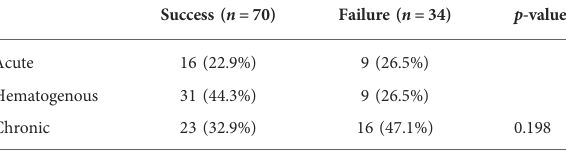
TABLE A1 Compare the failure rate of different types of infection with the cut off time as 4